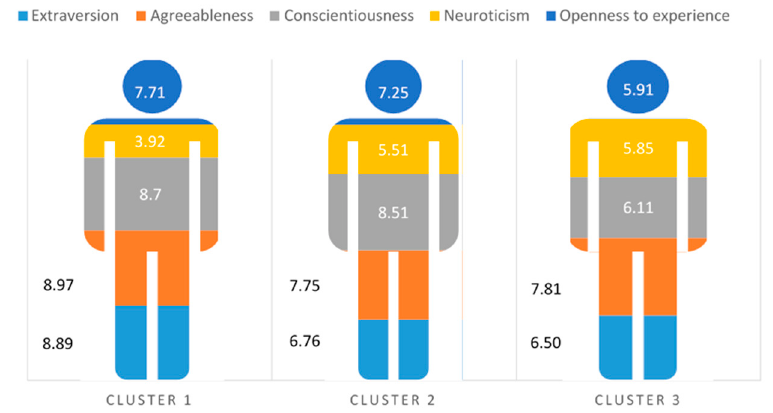
Figure 1. Mean scores on personality factors by cluster.